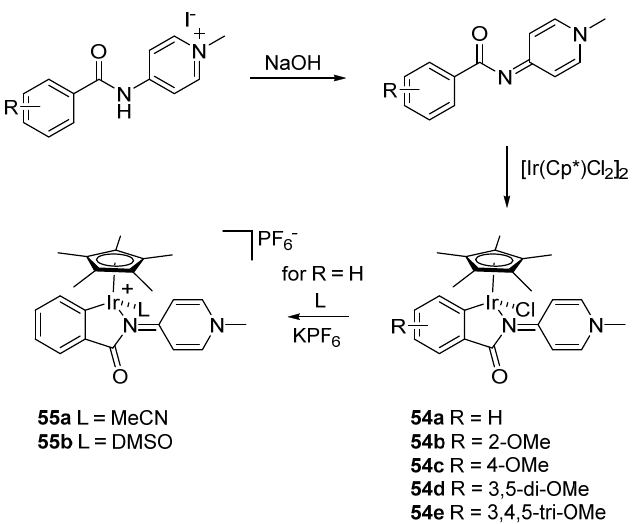
Molecules 2021 , 26 , x FOR PEER REVIEW 26 of 50